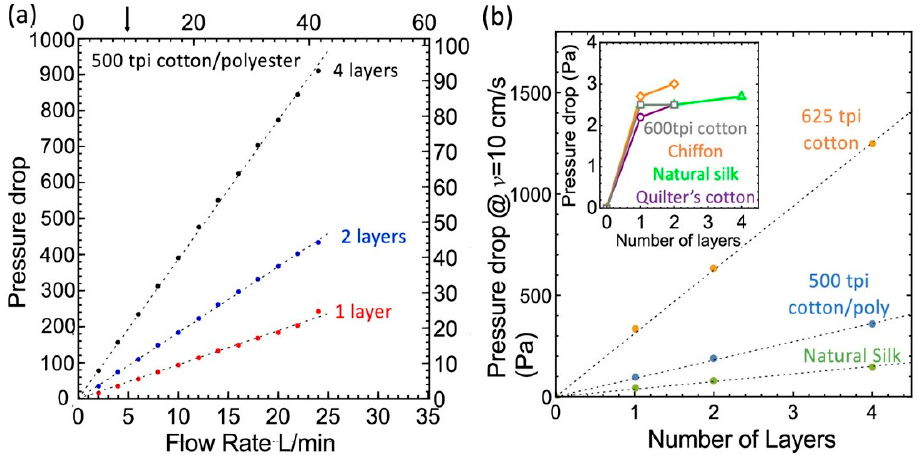
Figure 6. ( a ). Pressure drop vs. face velocity for 1, 2, and 4 layers of 500 thread per inch (tpi) cotton/polyester blend, and ( b ) Pressure drop at 10 cm/s face velocity for three materials [43].